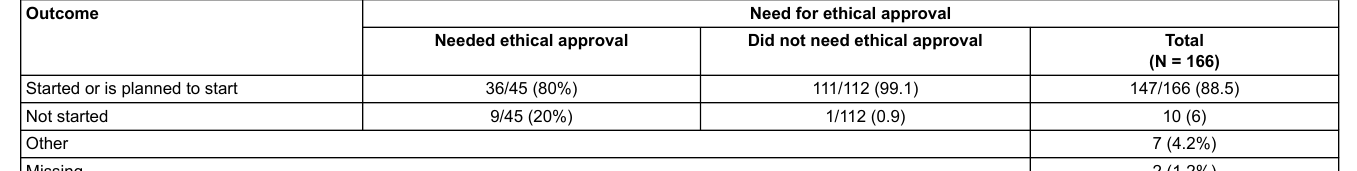
Table 6: Reported outcome of project.